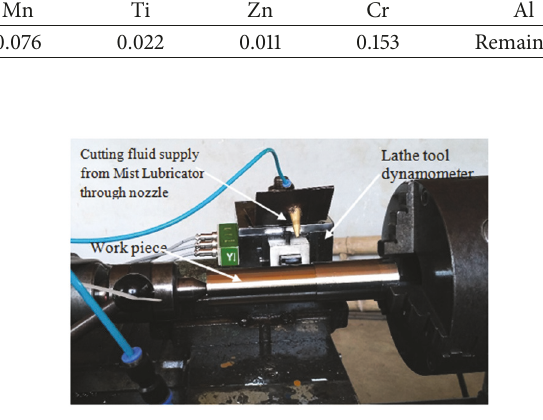
Figure 2: Experimental setup.